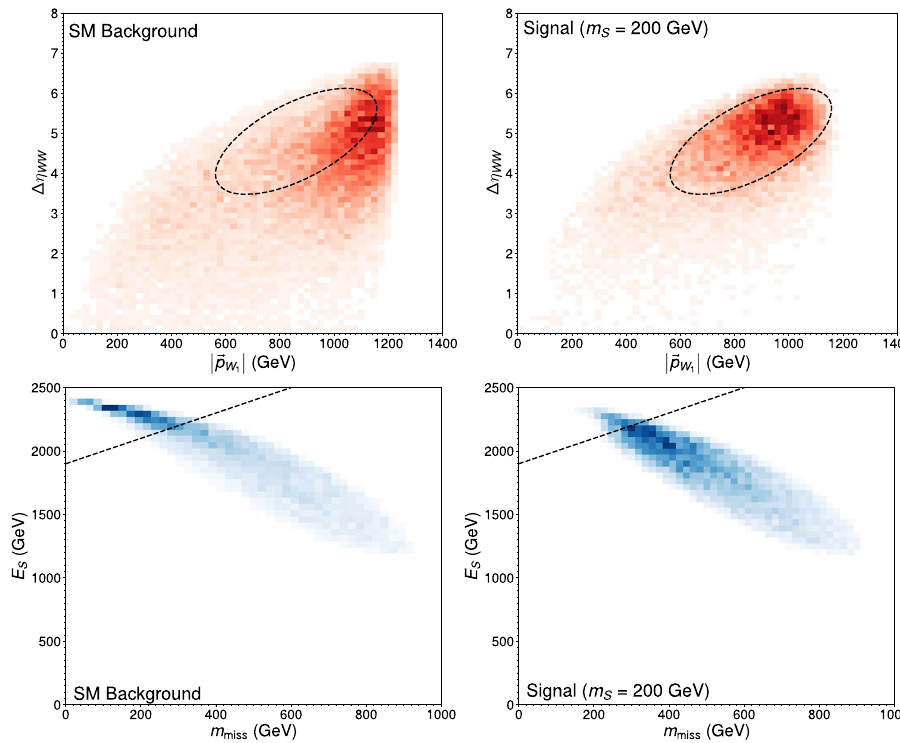
(cid:10) (cid:10) (cid:10) < 4 . 5, that are paired to reconstruct two W - (cid:10) η > 20 GeV and p j j T bosons), and the subsequent signal selection steps (see text for details). √ s | ee = 1 The cuts are the same for ILC with